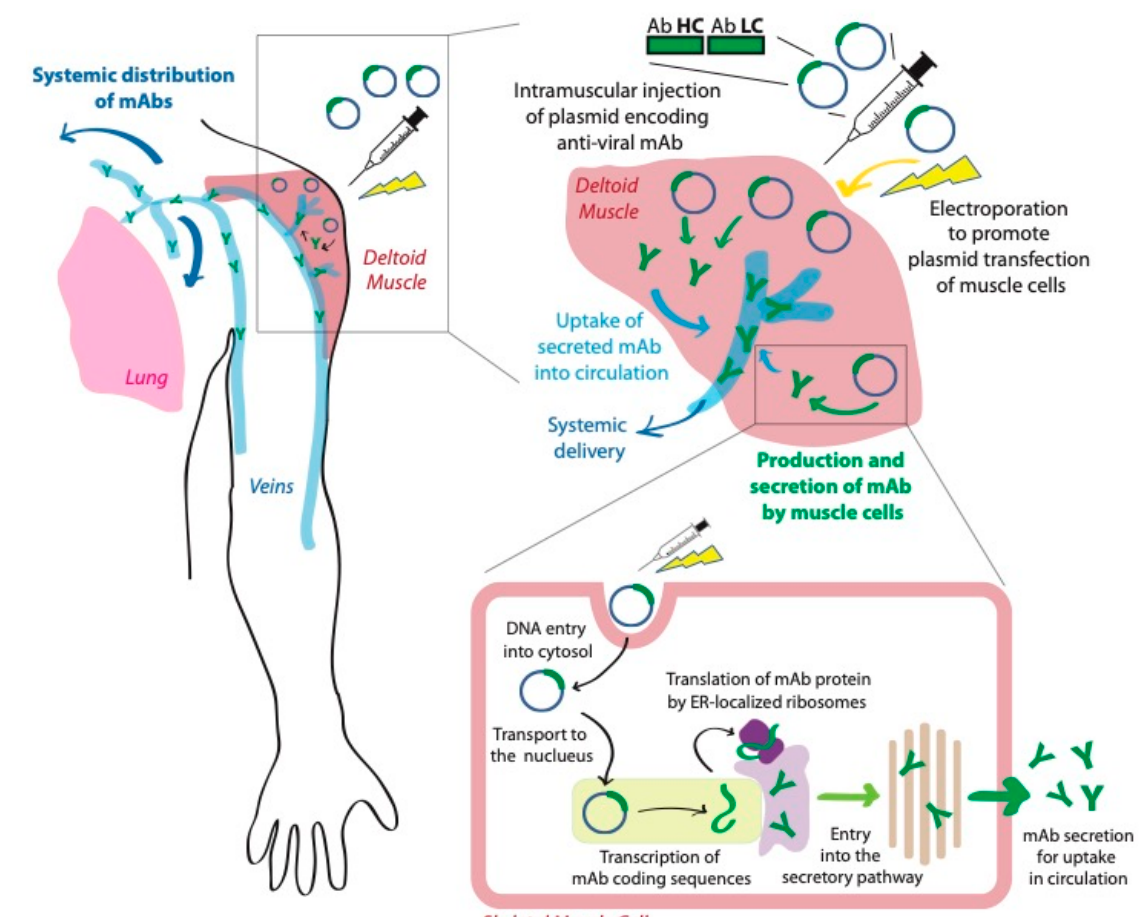
Figure 2. Delivery of monoclonal antibodies using electroporation-mediated administration of DNA. Intramuscular injection of plasmid DNA encoding a monoclonal antibody is followed by electroporation to promote uptake by muscle cells. Transfected muscle cells then use this genetic information to produce and secrete the encoded antibodies, which are then taken up into systemic circulation.